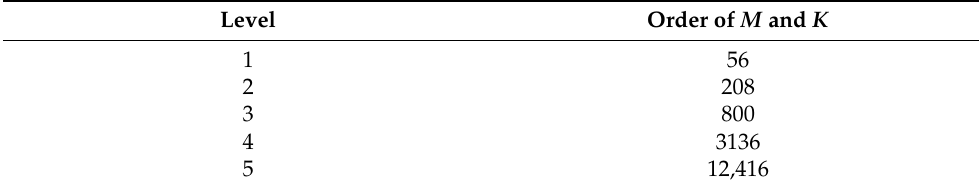
Table 1. Relationship between matrix order and level of mesh refinement (2D).